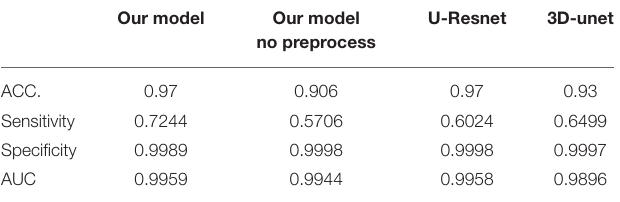
TABLE 4 | Models head-to head analysis.